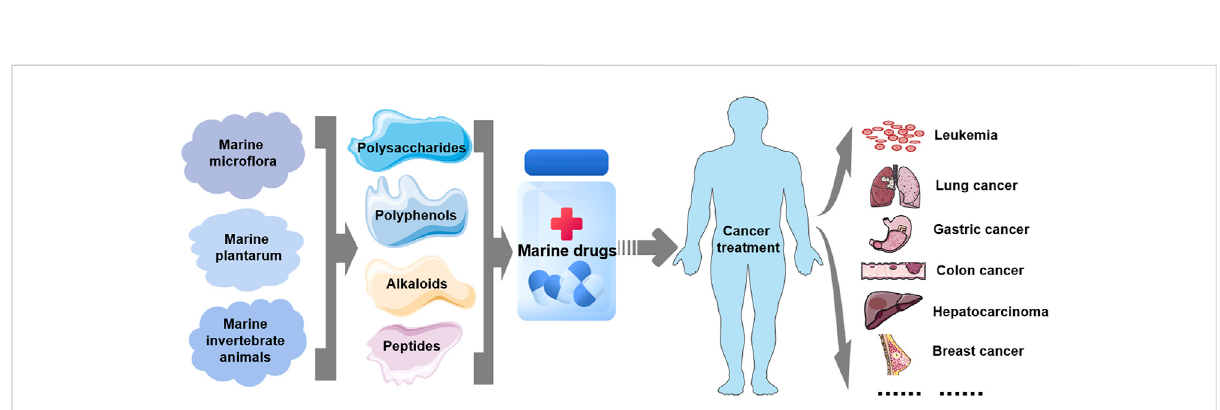
FIGURE 2 Marine-derived antitumor drugs. Antitumor substances of marine natural origin include polysaccharides, polyphenols, alkaloids, and peptides extractedfrommarineorganisms,includingmicro fl ora,plantsandinvertebrates.Atpresent,severalmarine-derivedantitumorsubstanceshavebeen used as drugs for the treatment of clinical human tumors, including leukemia and lung, gastric, colon, liver, breast, and liver